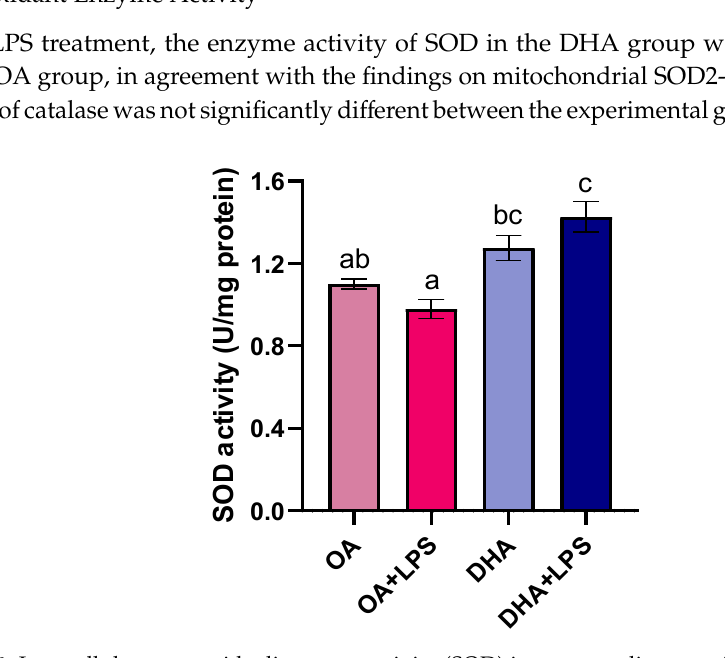
Figure 6. Intracellular superoxide dismutase activity (SOD) in mature adipocytes incubated for 6 days with 100 µM oleic acid (OA) or 100 µM docosahexaenoic acid (DHA) and thereafter exposed to lipopolysaccharide (LPS) for 20 h (OA + LPS and DHA + LPS, respectively). Data are presented as mean ± SEM ( n = 4). Di ff erent letters indicate significant di ff erences between treatments ( p < 0.05, ANOVA followed by Tukey’s post hoc